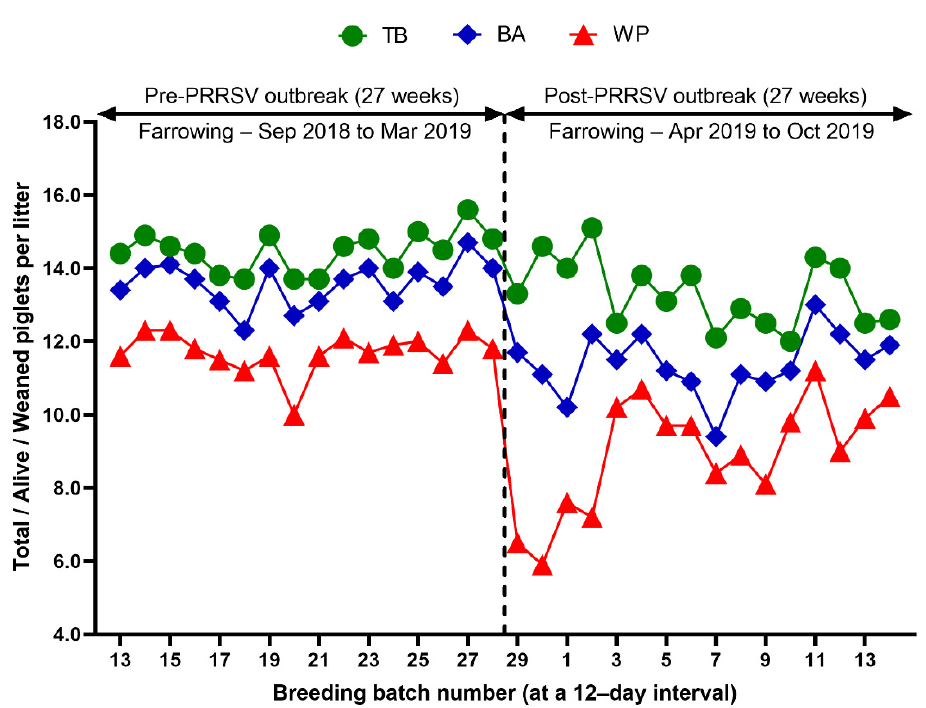
Figure 3. Comparison of the farrowing rate (FR), the abortion rate (AR), and the return rate (RR) before and after a PRRS outbreak.